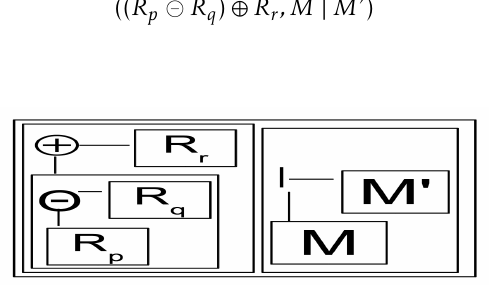
Figure 5. A context-aware action system for the extended (valid)